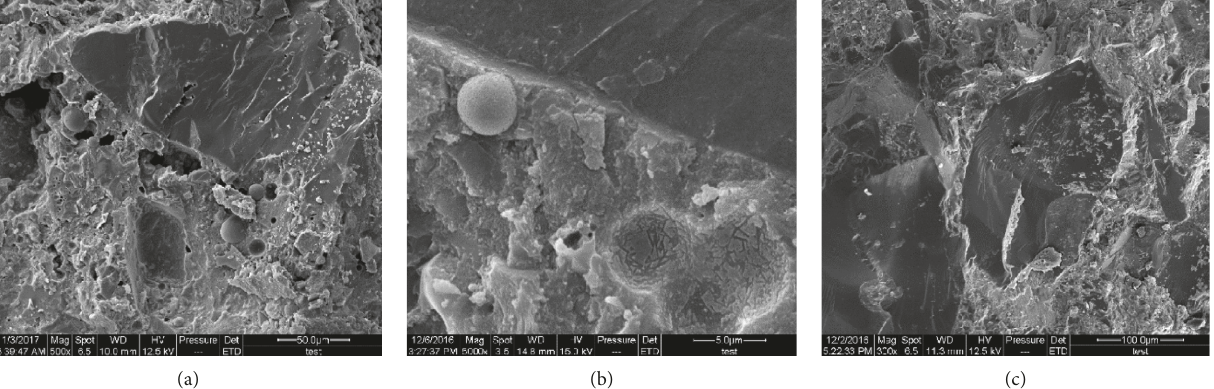
Figure 14: Microstructure evolution under standard curing conditions. (a) Standard curing W/B 0.3. (b) Standard curing W/B 0.35. (c) Standard curing W/B 0.4.